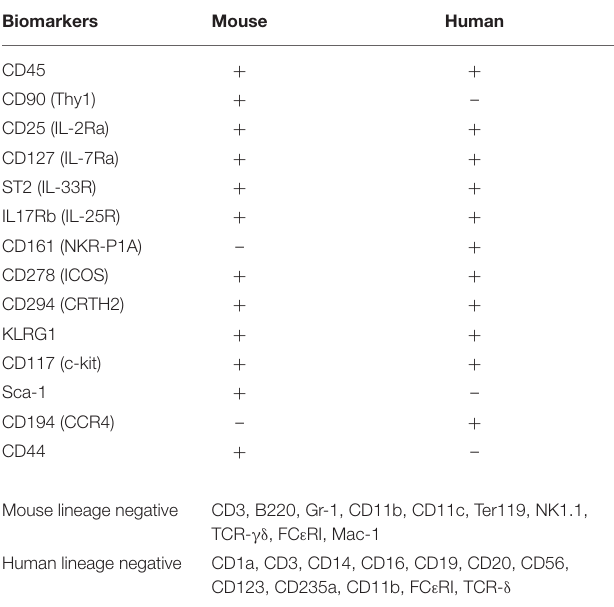
TABLE 1 | Mouse and human ILC2 markers.